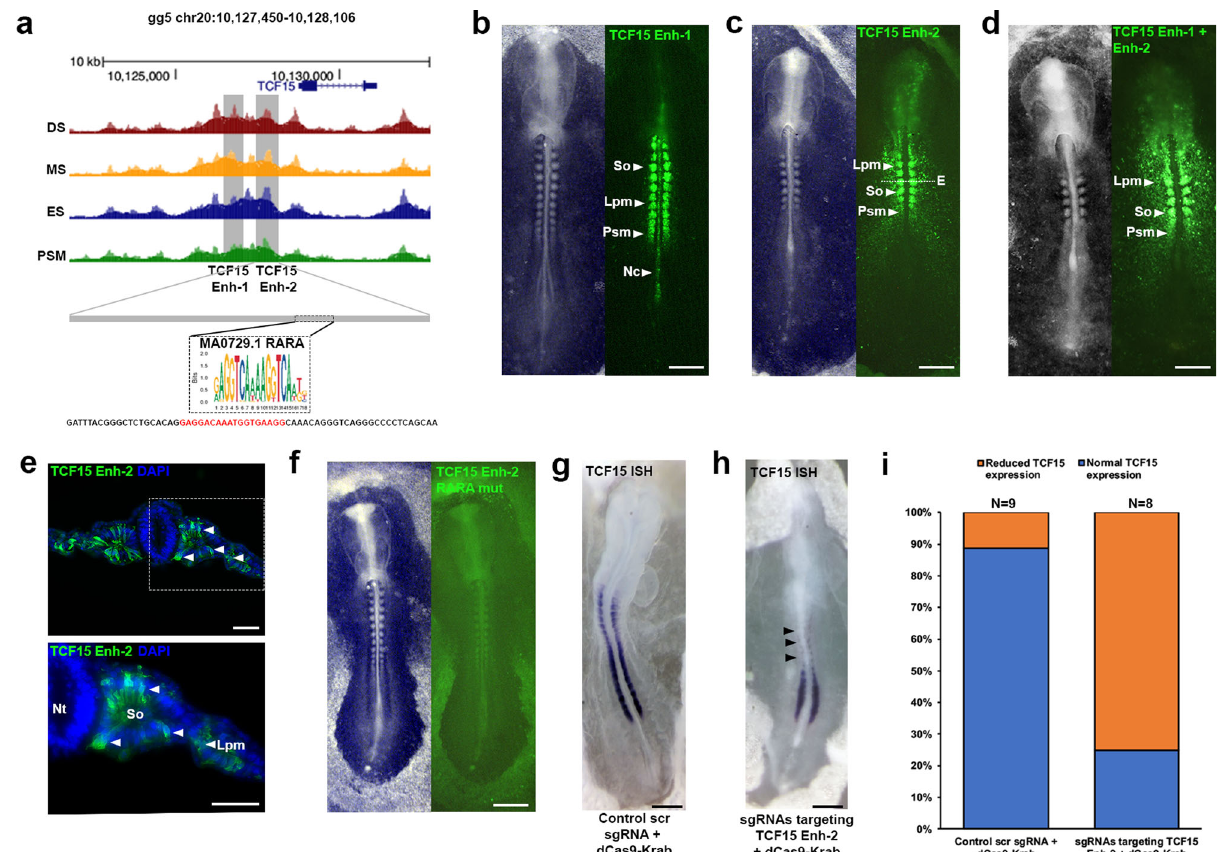
Fig. 5 Identi fi cation of a regulatory element for TCF15. a ATAC-seq pro fi le at the TCF15 locus. Grey boxes indicate putative enhancers identi fi ed ( TCF15 Enh-1 and TCF15 Enh-2). RARA footprint identi fi ed within TCF15 Enh-2. Mutant reporter sequence for TCF15 Enh-2 RARA mutant. b TCF15 Enh-1 ( n = 15/15) and c TCF15 Enh-2 ( n = 9/9) reporter expression in presomitic mesoderm (Psm), notochord (Nc), somites (So) and lateral plate mesoderm (Lpm). d Combined TCF15 Enh-1/Enh-2 reporter expression ( n = 9/9). e Transverse sections of embryo in c immunostained for Citrine showing TCF15 Enh-2 expression in somites and lateral plate mesoderm, white dashed line in c indicates location of section, representative of ( n = 4/4). Nuclei stained with DAPI (blue). f TCF15 Enh-2 Citrine reporter with RARA binding site mutation displays lack of expression in somites ( n = 6/6). Epigenome engineering using dCas9-Krab with ( g ) control scrambled sgRNAs resulted in no change ( n = 8/9) and ( h ) sgRNAs targeting endogenous RARA binding site led to loss of TCF15 expression ( n = 6/8) as shown by wholemount in situ hybridisation. i Percentage of embryos with normal (blue) or reduced (orange) TCF15 in situ expression after electroporation of control scrambled sgRNA with dCas9-Krab or sgRNAs targeting TCF15 Enh-2 RARA binding site with dCas9-Krab. All scale bars = 500 μ m except for e scale bar = 100 μ